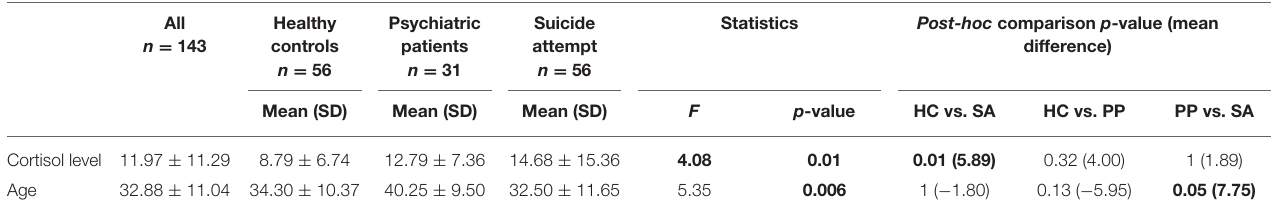
TABLE 2 | Comparison of cortisol levels and age among